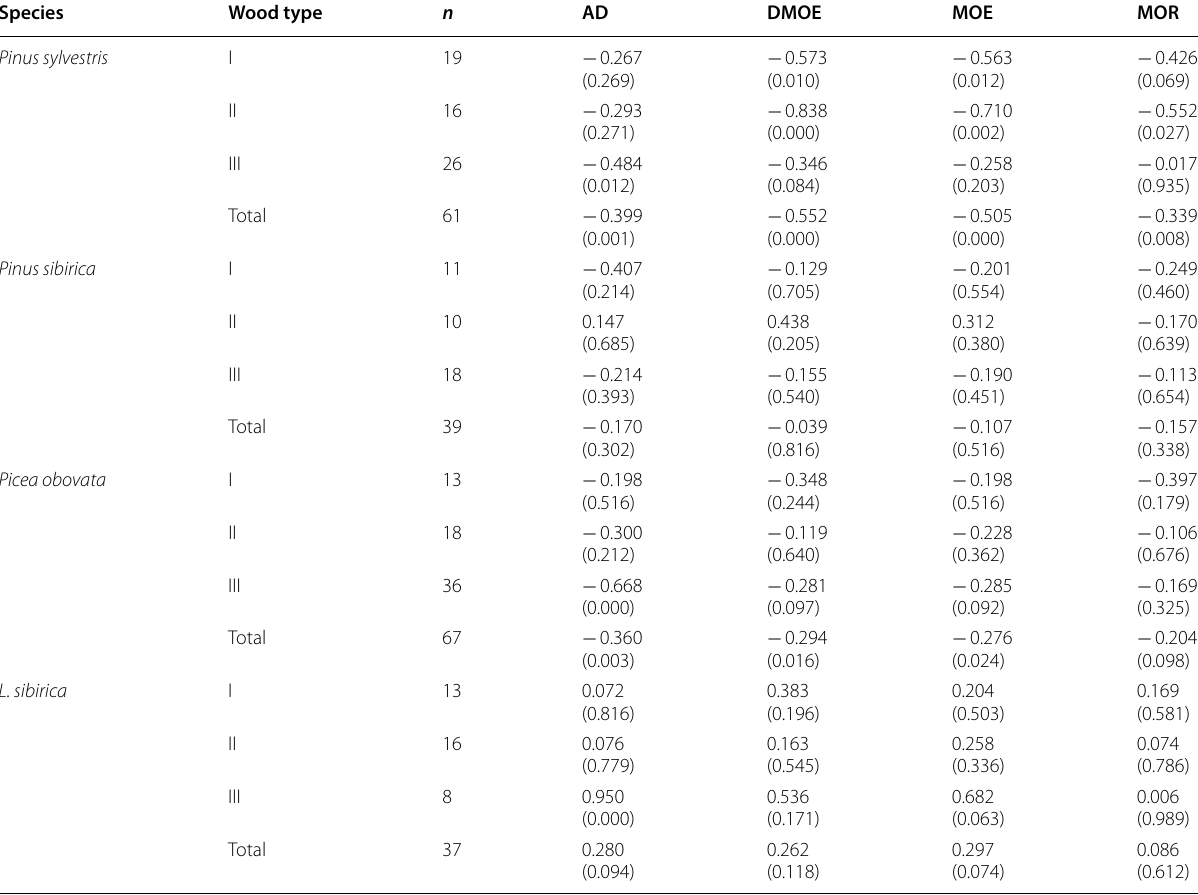
Table 7 Correlation coefficients between annual ring width and lumber properties in each wood type Species Wood